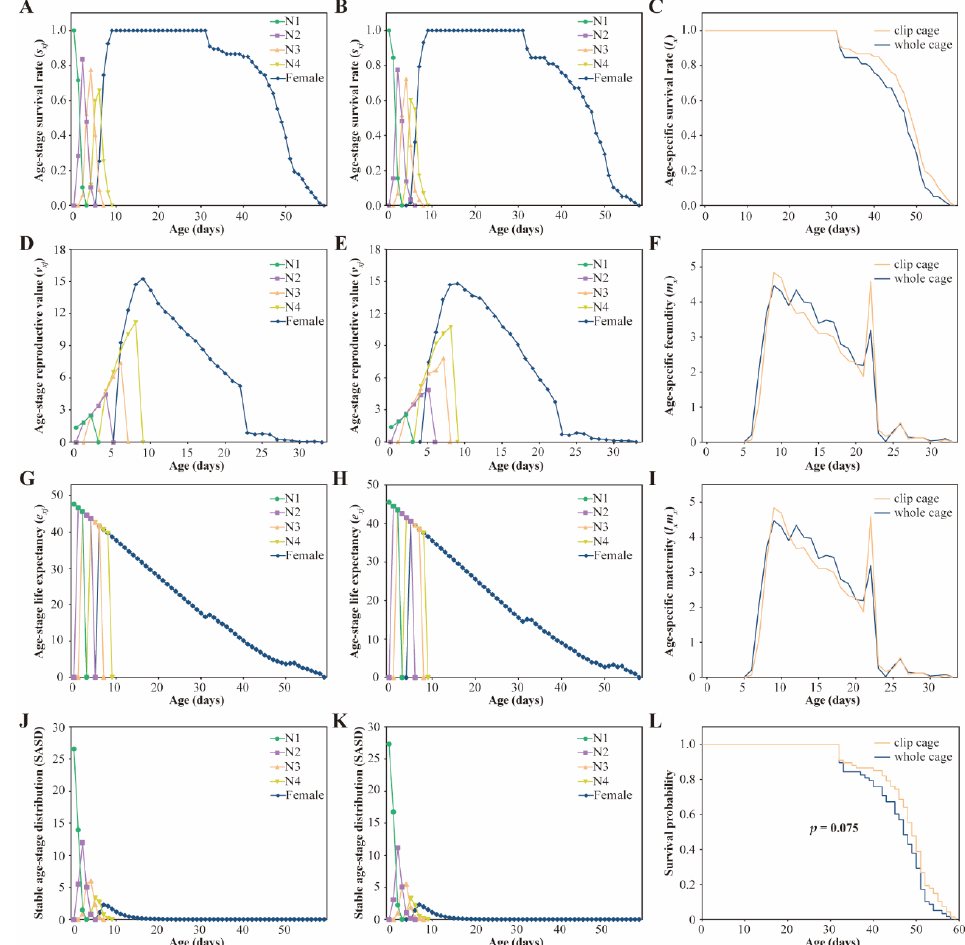
Figure 4. (A,B) Age-stage survival rate ( s xj ), (C) age-specific survival rate ( l x ), (D,E) age-stage repro- ductive value ( v xj ), (F) age-specific fecundity ( m x ), (G,H) age-stage life expectancy ( e xj ), (I) age-spe- cific maternity ( l x m x ), (J,K) stable age-stage distribution (SASD), and (L) survival probability of Sito- bion avenae confined to clip cages ( A,C,D,F,G,I,J,L ) and whole cages ( B,C,E,F,H,I,K,L ). Kaplan – Meier curves were constructed and log – rank (Mantel – Cox) tests were performed to detect differ- ences in survival probability between the two cage groups. N1: first instar nymph; N2: second instar nymph; N3: third instar nymph; N4: fourth instar nymph. To further validate the applicability of the clip cages, the nymph mortality and adult fecundity were investigated. No significant difference was observed in the nymph mor- tality ( p = 0.772) between the clip cage and whole cage groups, which were 8.615% ± 1.181% and 7.071% ± 0.984%, respectively (Figure 5A). For adult reproduction, five third or fourth instar nymphs produced 44.200 ± 0.987 and 45.985 ± 0.990 offspring within 6 days in the clip cage and whole cage groups, respectively (Figure 5B). Differences in adult fecundity between the two groups were not detected by the unpaired t -test ( p = 0.202) (Figure 5B); thus, the clip cages can be used for aphid antibiosis research.